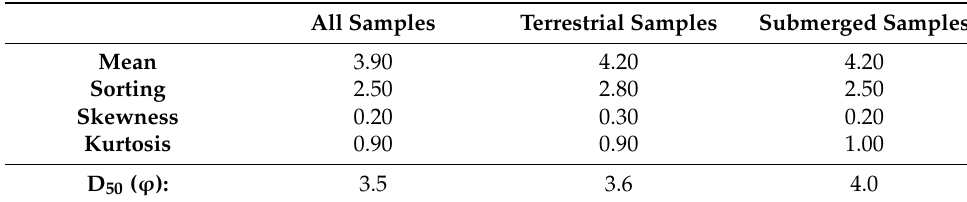
Table 2. Average particle size data for all samples (including the two soil samples), terrestrial and submerged samples.